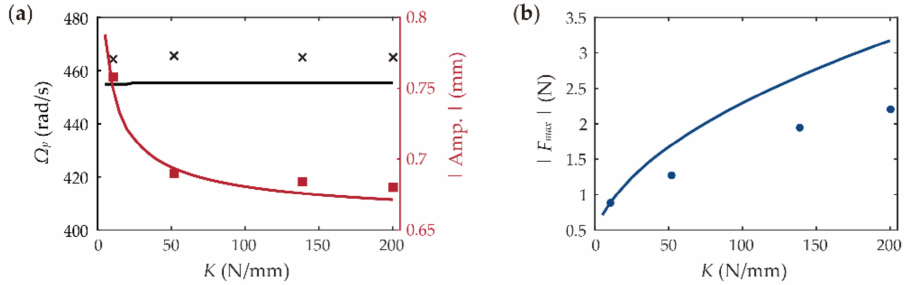
Figure 14. Experimental and modelling results on the effects of constraint stiffness on ( a ) peak frequency and oscillation amplitude and ( b ) peak impact force. The discrete markers indicate the experimental data and the continuous curves are the modelling